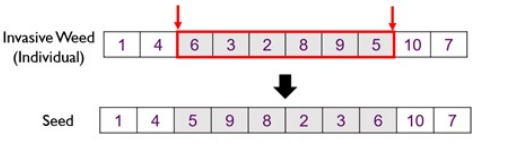
Fig. 7. Spatial dispersal